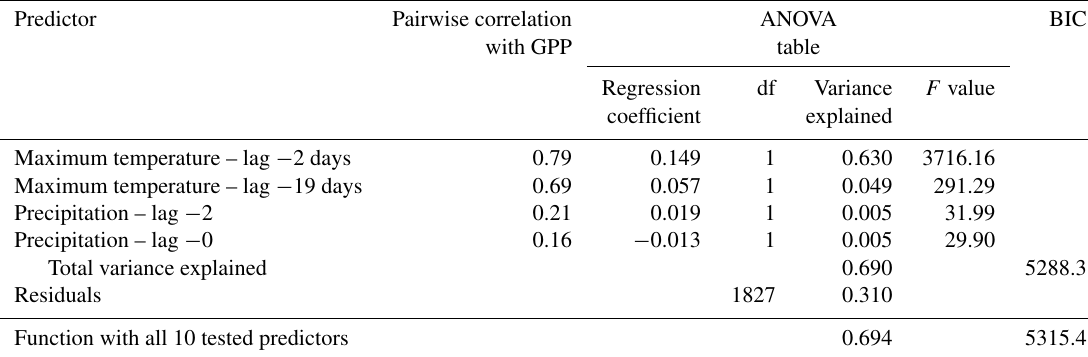
Table 2. ANOVA table for the best response function (here, a combination of 4 of the 10 tested predictors minimized the BIC) with daily GPP at EOBS as dependent variable (excluding days between 15 November and 1 April). All F values are highly significant ( p < 0 . 001). For precipitation, lag n indicates the sum of the daily precipitation of the week ending in day n .